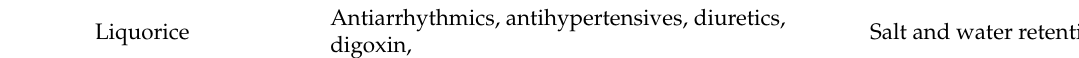
Table 2. Drug and nutritional status interaction. Mechanisms underlying nutritional status changes are discussed in the text.